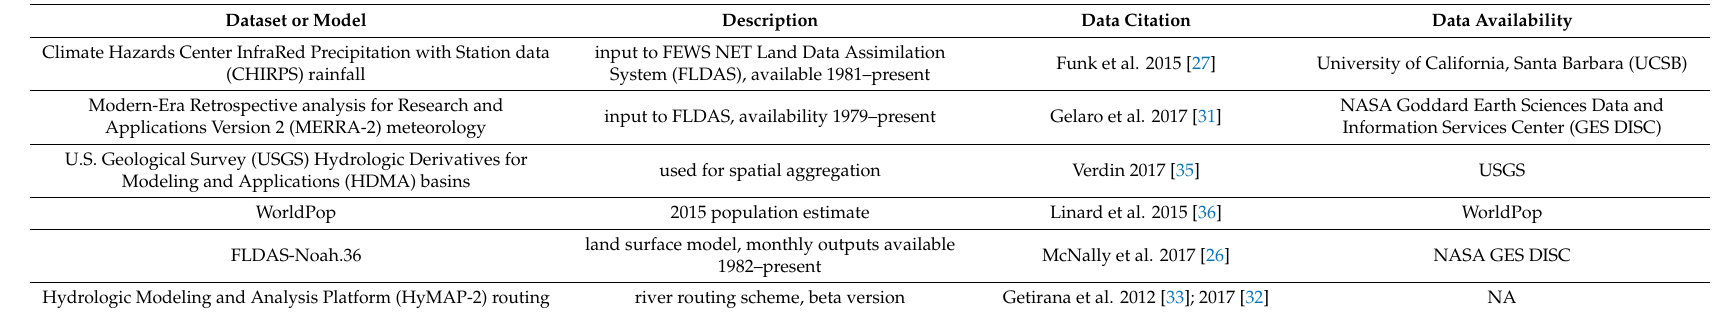
Table 1. Datasets used for routine water scarcity